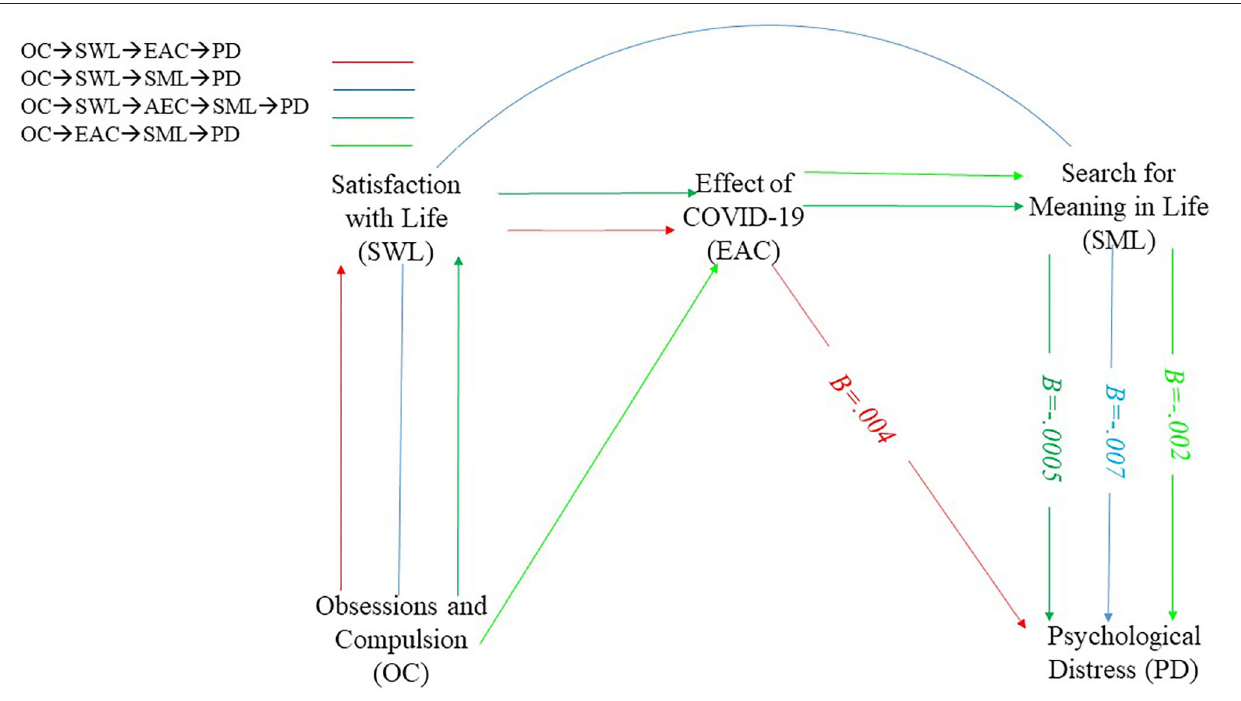
FIGURE 2 | Serial mediation